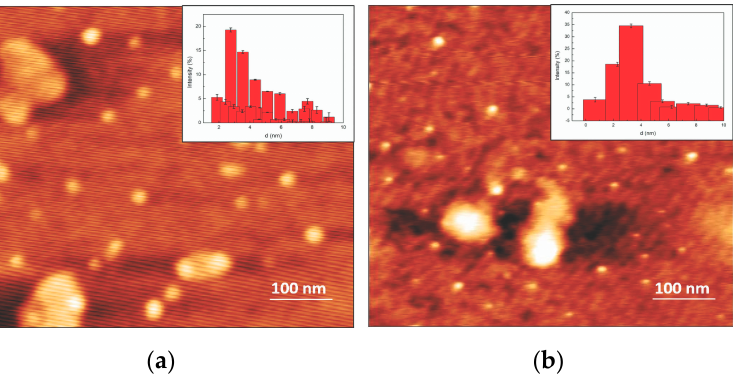
Figure 1. AFM images and histograms of ( a ) Mo nanoparticles (NPs), ( b ) Ni NPs.